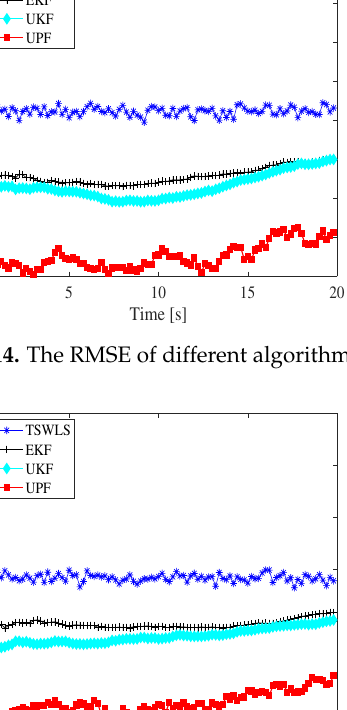
Figure 15. The RMSE of different algorithms in LOS scenario ( σ θ